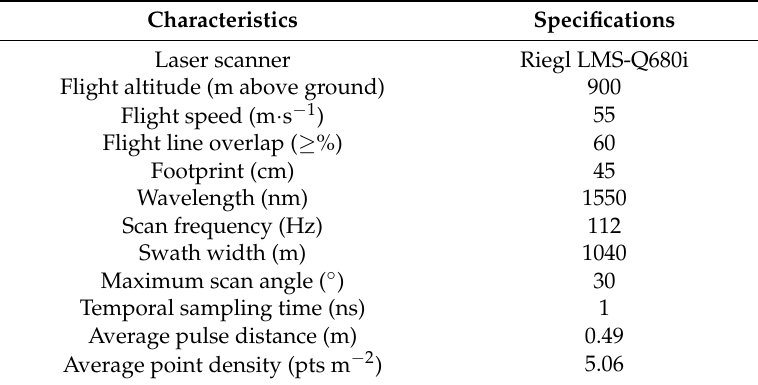
Table A2. Properties of LiDAR sensor and parameters of data acquisition.